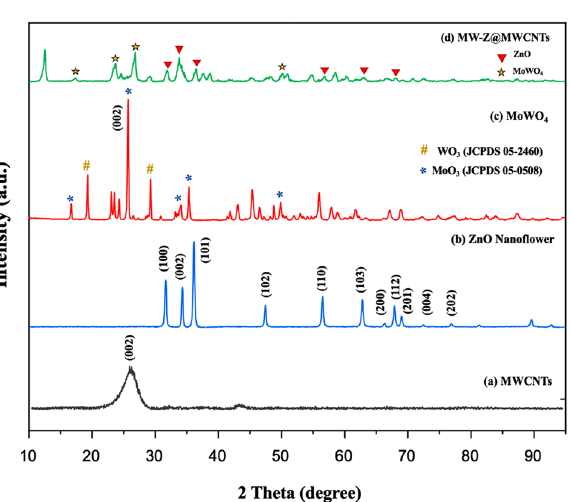
Figure 2. XRD patterns of ( a ) MWCNTs, ( b ) ZnO nanoflowers, ( c ) MoWO 4 , and ( d )